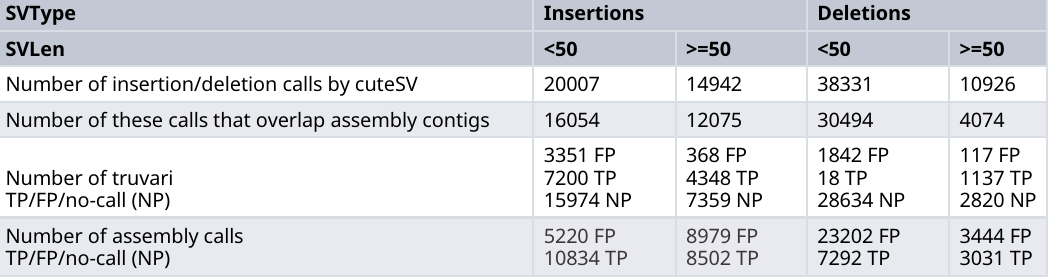
Table2.Summary: Insertionanddeletioneventsarecomparedaccordingtostructuralvariantsizeandnumberand overlapswiththehaplotypedassemblyusedintheirperformedevaluation.Truvariclassificationfortheoverlapping calls are shown as well as TP and FP found in the haplotyped